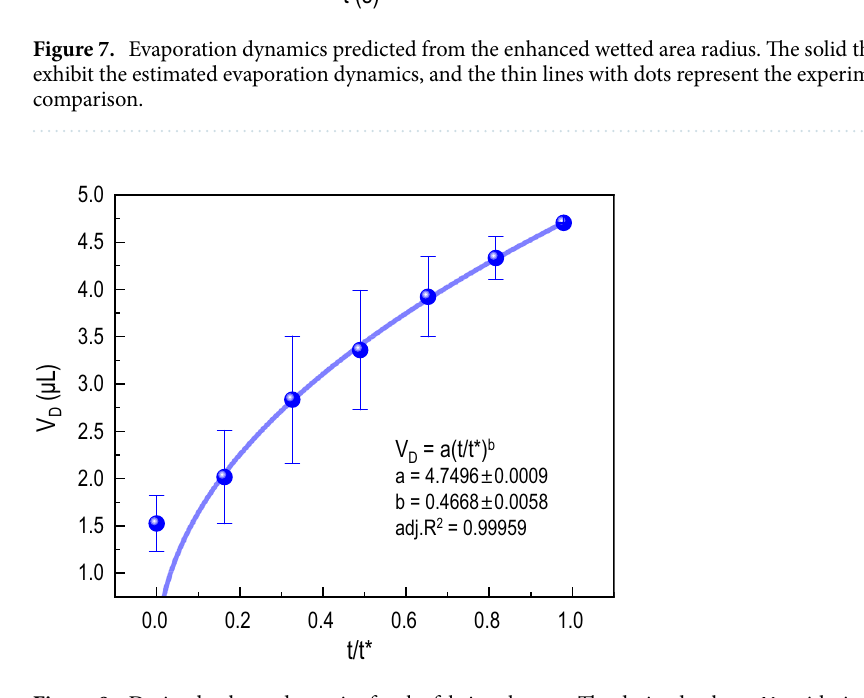
Figure 8. Drained volume dynamics for the fabric substrate. The drained volume V D with time t (normalized to the characteristic time constant t ∗ ) is examined with the power law V D = a ( t / t ∗ ) b . The fitting result represents a 1 / 2 relationship of V D ∼ t